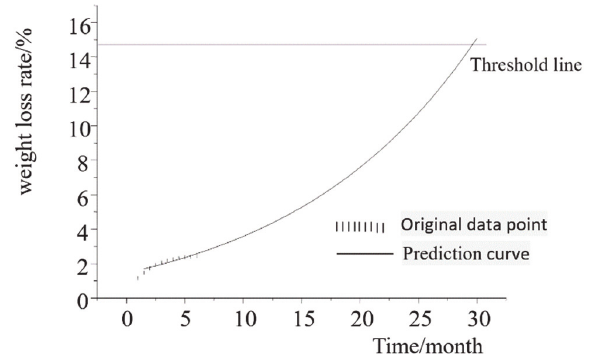
Figure 5. The Prediction curve and original data point at weak acidity aqueous soaking